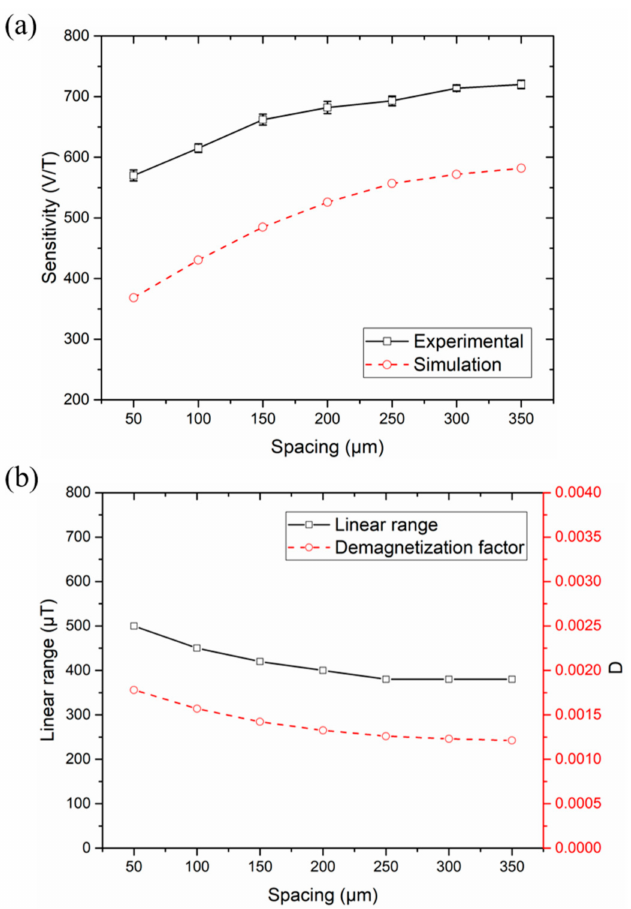
Figure 6. ( a ) The sensitivity of experiment and simulation as a function of the spacing between strips. ( b ) The linear range as a function of the spacing between strips, and the comparison with the demagnetization factor D .